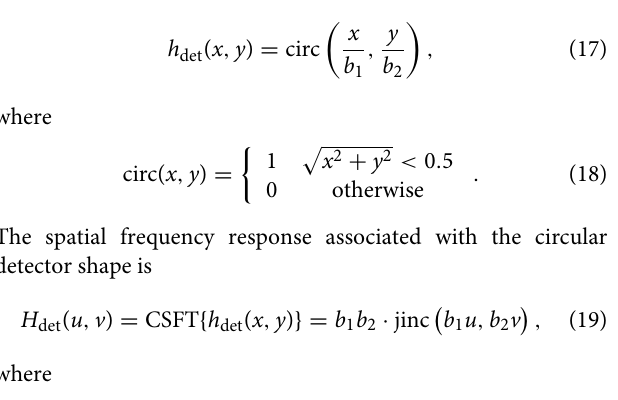
In division of FPA sensors like Bayer pattern color sensors, multiband, and polarimetric imagers, a single FPA uses detector elements of different types in alternating patterns. An example of a polarimetric division of FPA array is shown in Figure 9 [14,